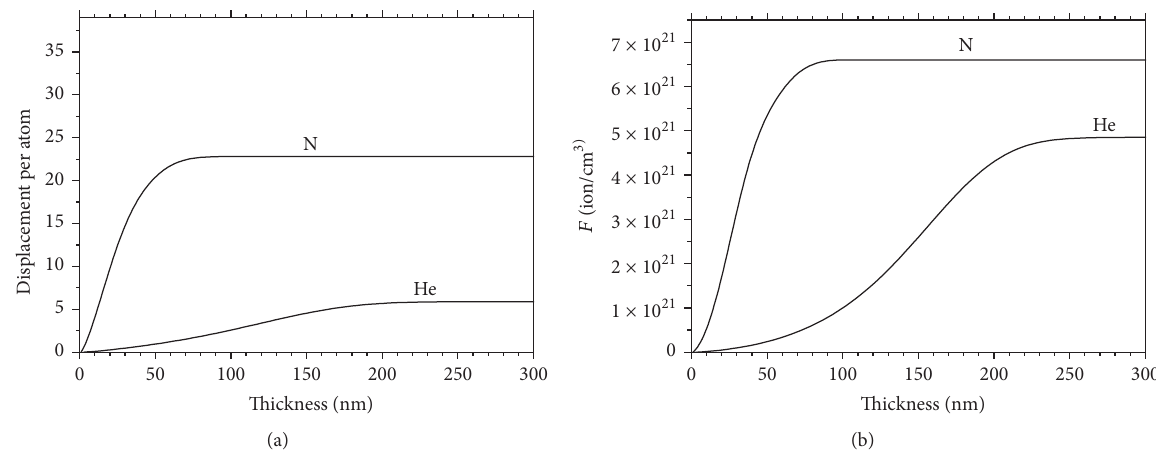
Figure 1: Thickness dependencies of damage distribution (displacement per atom) (a) and implanted helium and nitrogen atoms (b) in the V-N-He film; 𝑈 = 30 kV, V/(N 2 + He) = 0.5